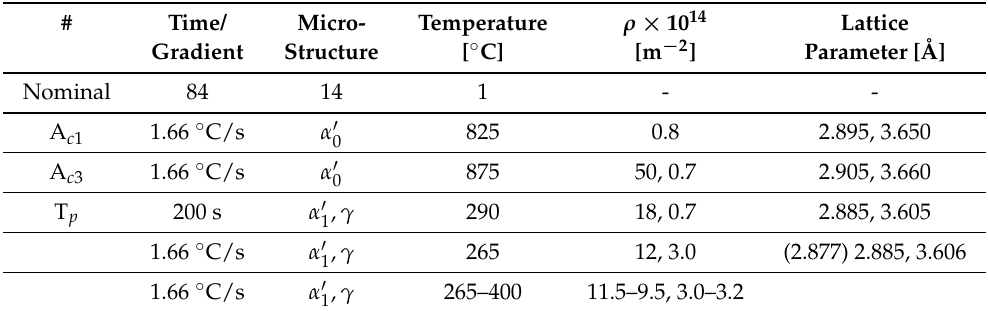
Table A1. Temperature cycle with microstructure results after the conducted Q&P heat treatment for the X20Cr13 stainless